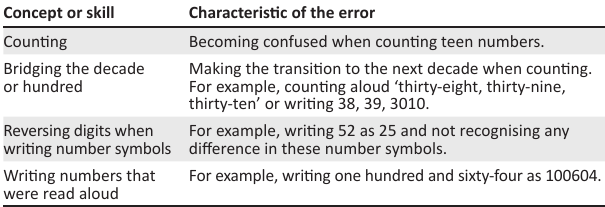
TABLE 2: Counting errors related to place value. Concept or skill Characteristic of the error Counting